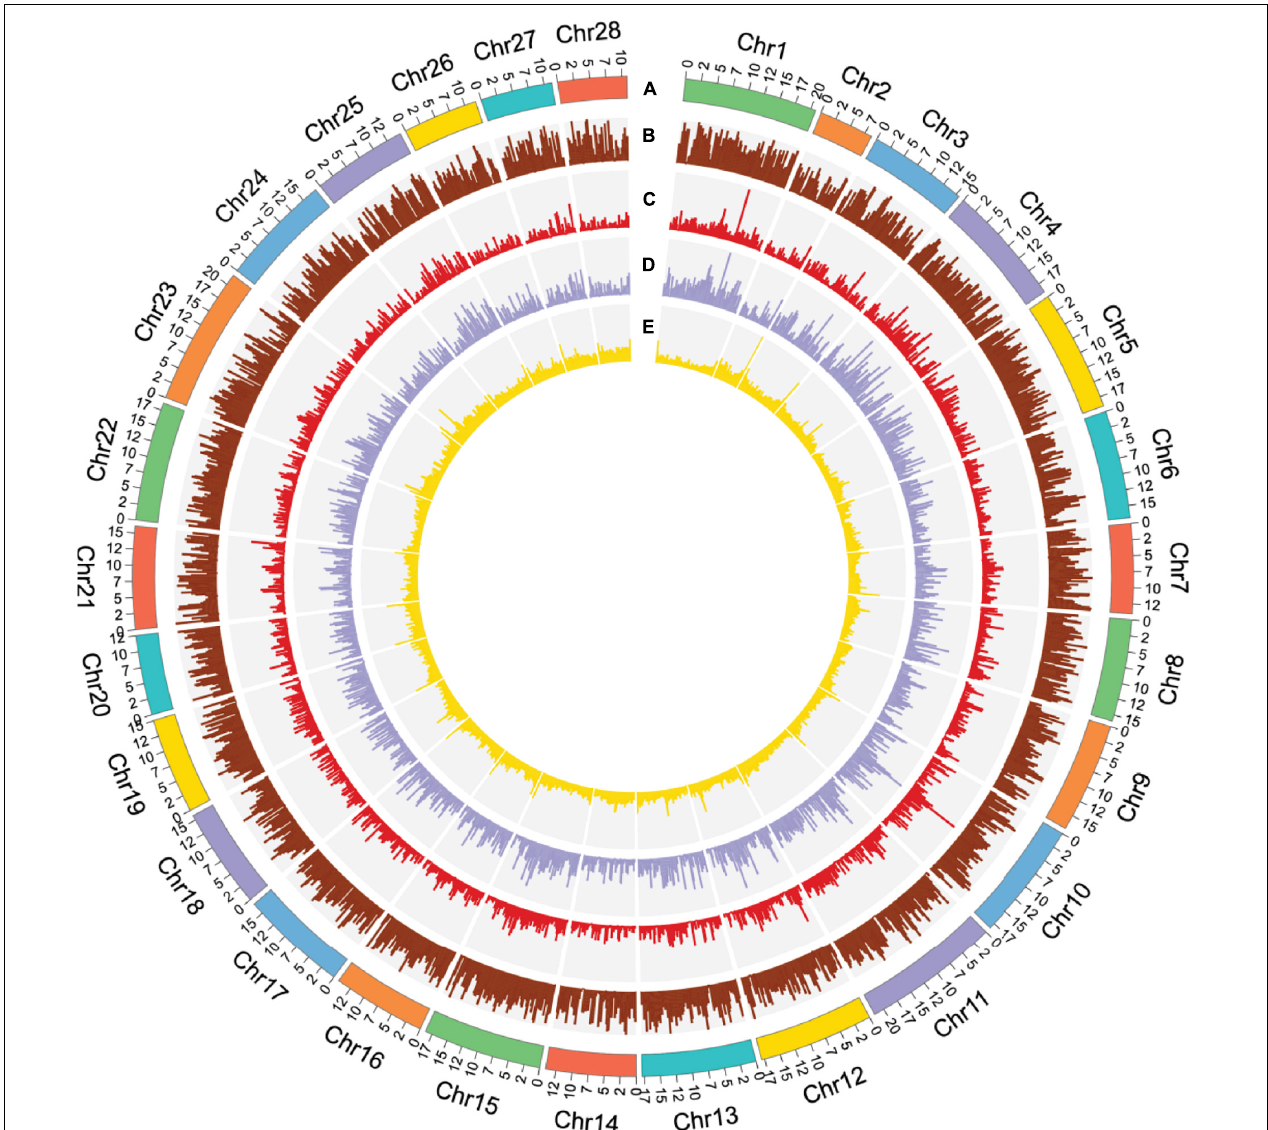
FIGURE 1 | Summary of gene distribution and genetic diversity across the 28 chromosomes. (A) Chromosome position. (B) Gene density in 200-kb windows. (C) CDS density in 200-kb windows. (D) Exon density in 200-kb windows. (E) GC content in 200-kb windows.